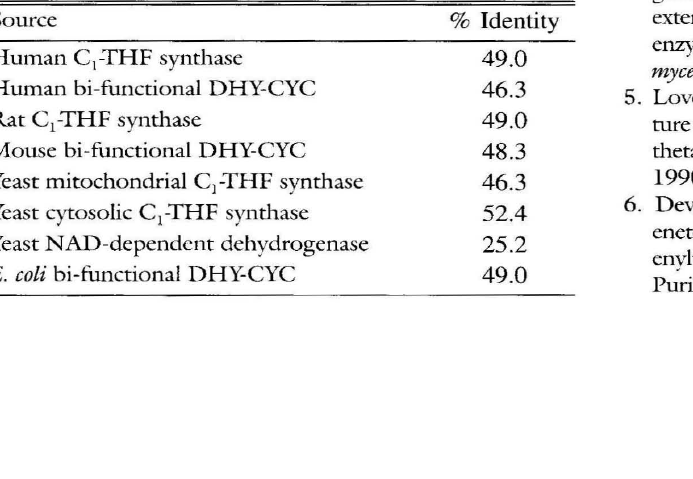
Table 1. Percentage identity shown between the amino acid sequence of pea DHY-CYC and the corresponding enzymes or domains of other